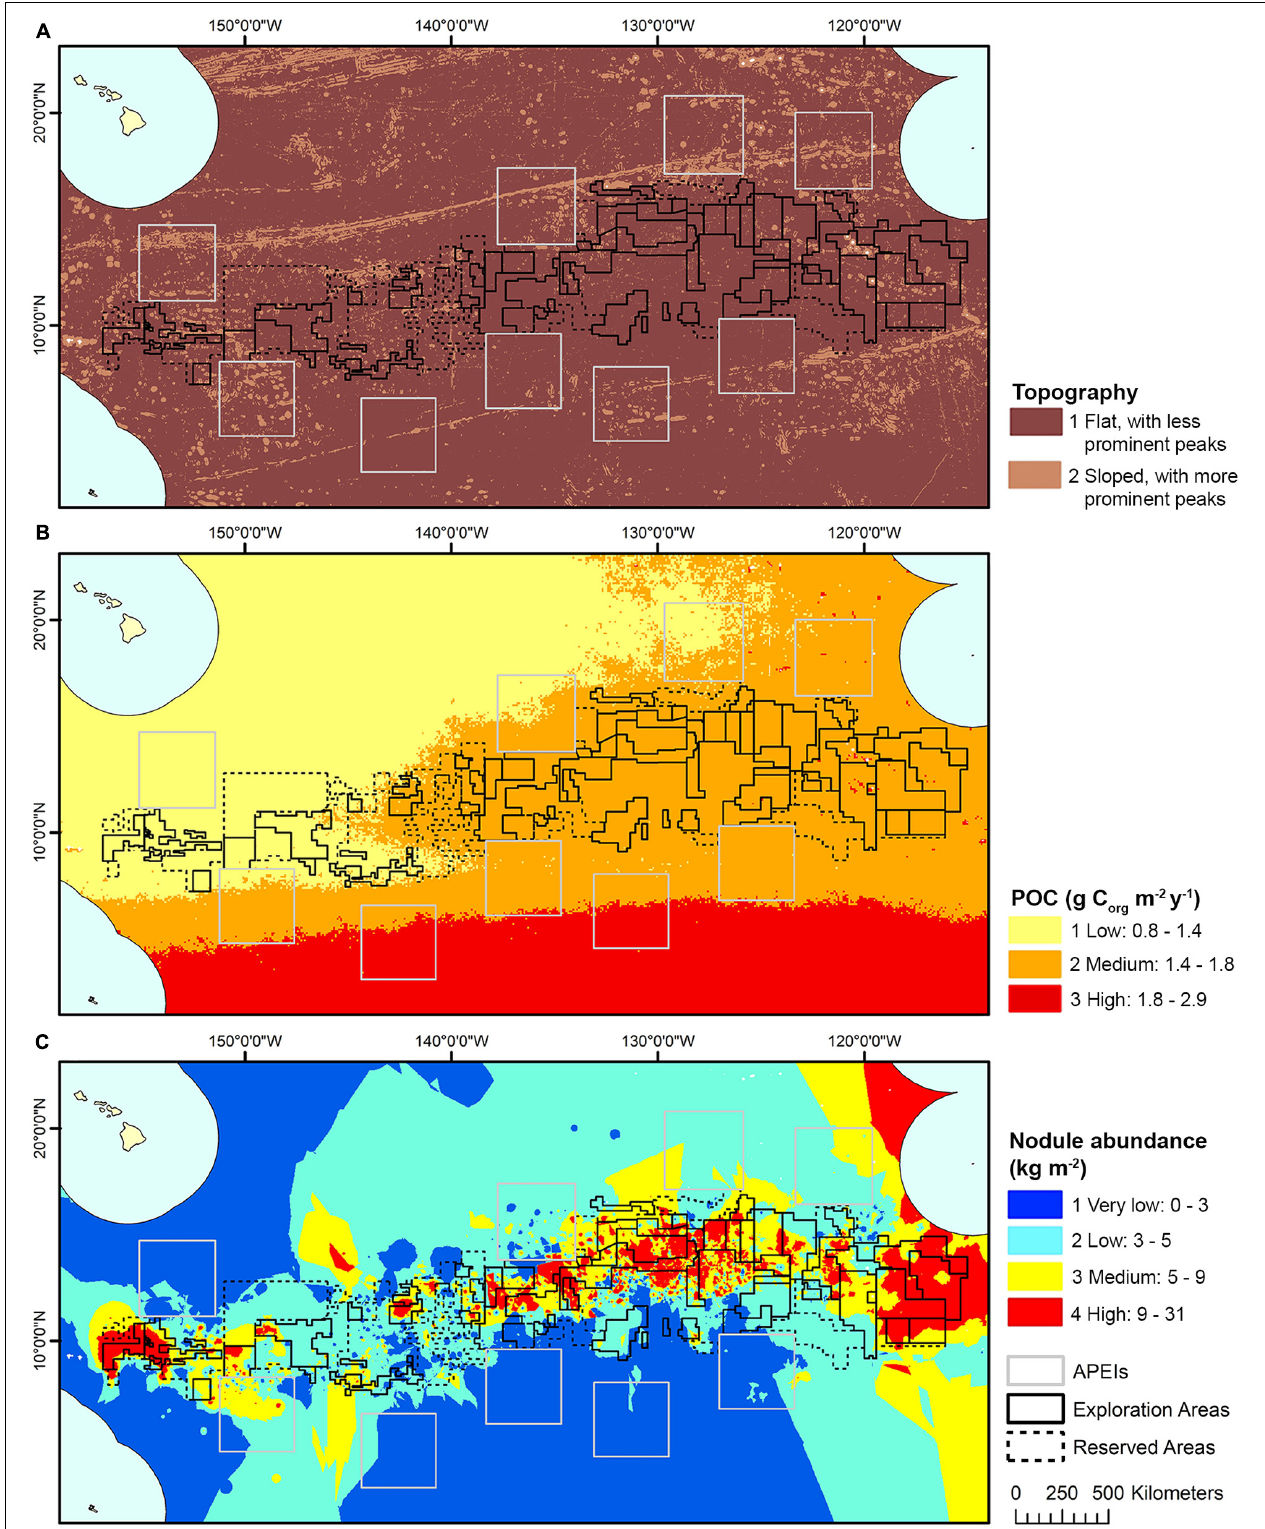
FIGURE 4 | Outputs of initial CLARA clustering on variable classes to represent (A) topography, (B) seafloor POC flux, and (C) nodule abundance in the CCZ region, used in the final habitat classification.